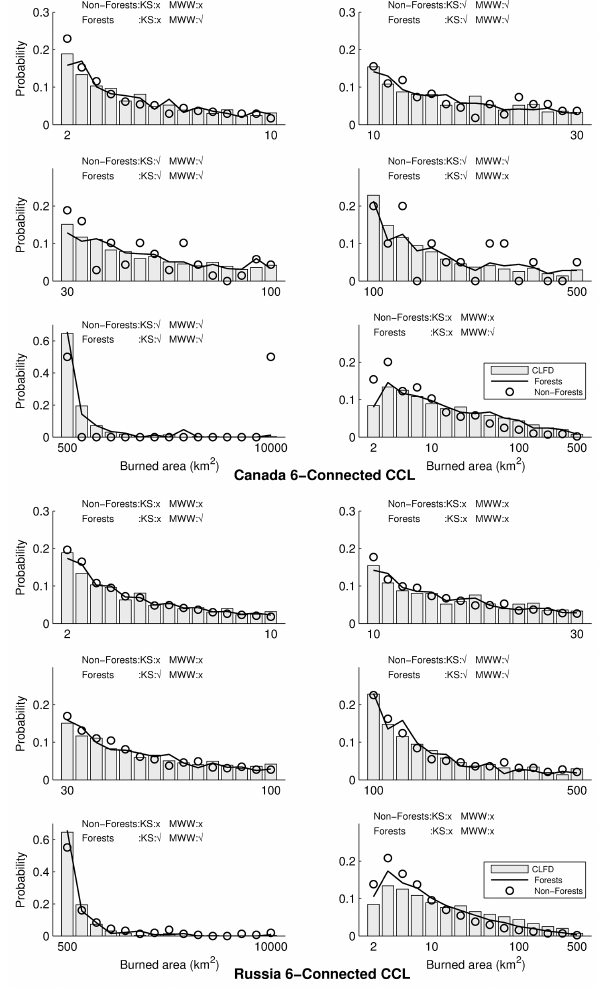
Figure 2. Histograms of area burned in each fire size category ob- tained from the CLFD and the application of 6-connected CCL to the GFED burned area daily product. The CLFD results only de- scribe forest fires in Canada, while the CCL-6 results are given separately for forests and non-forests in Canada (top) and Russia (bottom). The limits of the x axes in each figure give the range of burned area studied in each category; the x axis in the bottom right figure for each region uses a logarithmic scale. A tick or cross shows whether the CCL-derived distributions for forests and non-forests pass or fail the Kolmogorov-Smirnov (KS) and Mann-Whitney- Wilcoxon (MWW) test when compared to their size-respective CLFD